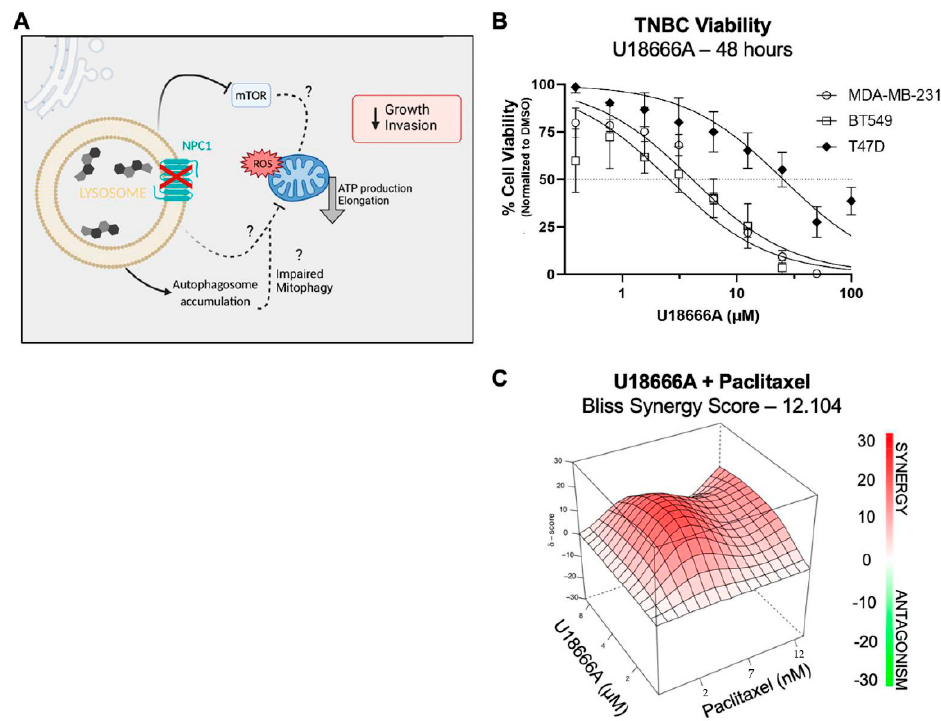
Figure 6. NPC1 has therapeutic potential alone and in combination with chemotherapies in TNBC. ( A ) A graphical summary of the anti-tumor effects of NPC1 silencing. Created with biorender.com ( B ) Dose-response curves of U18666A in TNBC (MDA-MB-231, BT549) and ER+ (T47D), 48 h drug treatment as analyzed by crystal violet. Linear regression with a variable slope. ( C ) Additive and synergistic effects of U18666A and Paclitaxel in BT549 cells. Three doses of each drug were given for 48 h and analyzed by crystal violet. The additive/synergy effect was analyzed and calculated using SynergyFinder 2.0.